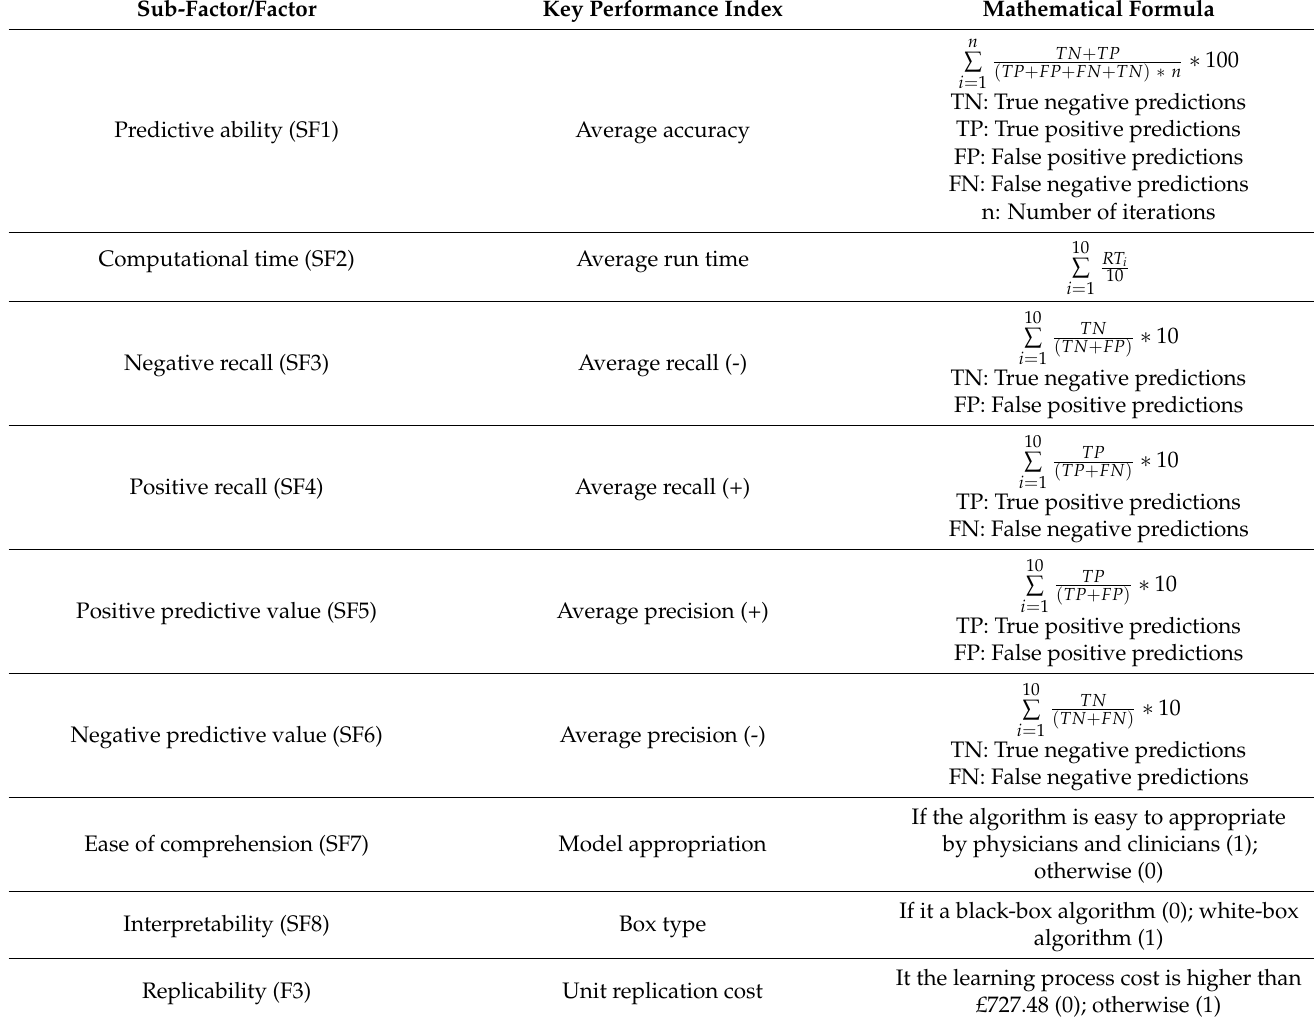
Table 5. List of key performance indexes utilized in the modified